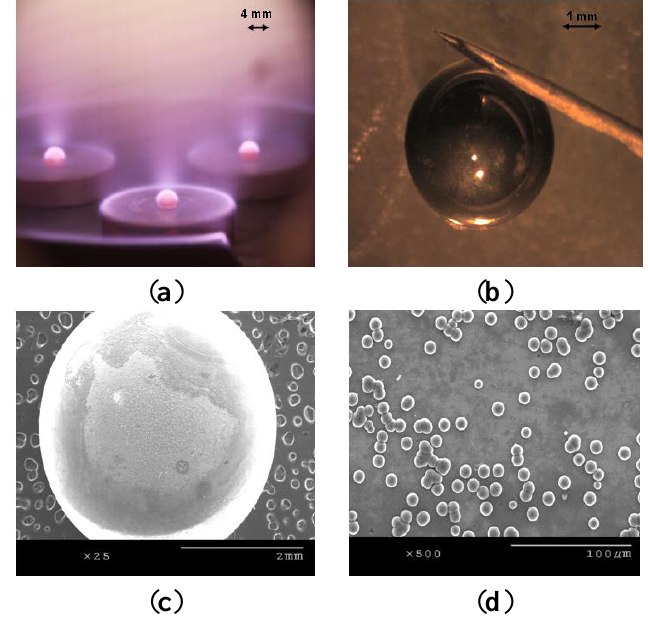
Figure 6. ( a ) Multiple silicon spheres being processed in a 30 kW CVD chamber; ( b ) Nanodiamond coated silicon sphere. Smooth surface is reflecting the needle held close to it; ( c ), ( d ) show areas where non uniform growth of NSD has been observed on silicon